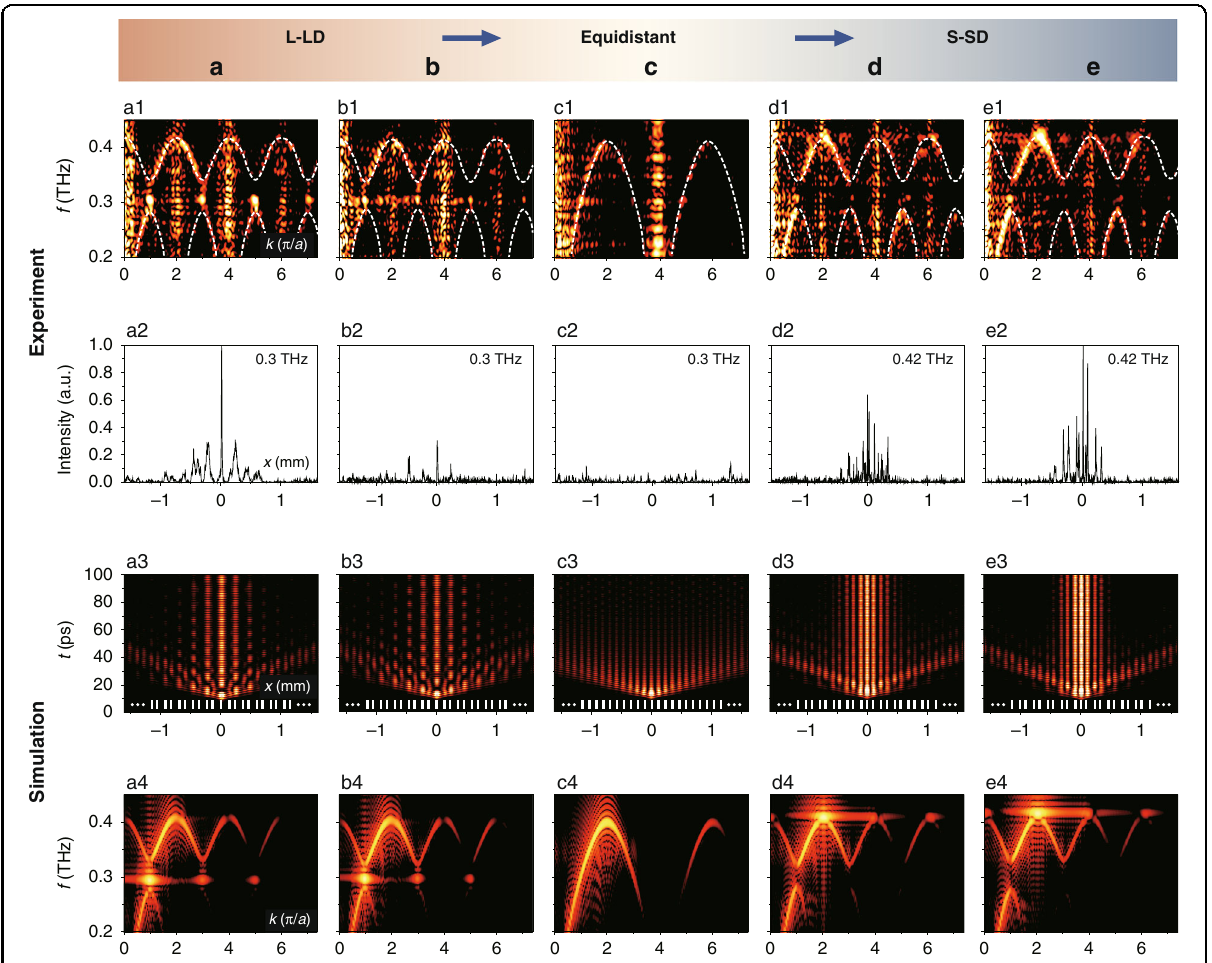
Fig. 3 Experimental (top two rows) and numerical (bottom two rows) demonstrations of topologically controlled THz con fi nement in the LN chip from L-LD, through equidistant, to S-SD regions of the wedge-shaped SSH photonic lattice. a – e correspond to locations (A – E) marked in Fig. 1b. a1 – e1 Measured spectra at the corresponding positions. a2 – e2 Energy distribution of the modes showing different con fi nement of the generated THz waves in the LN chip. a3 – e3 Simulated x − t diagrams showing the THz waves evolution in different regions, where a4 – e4 are the corresponding spectra. The lattice sites are illustrated by white tick marks in a3 – e3 , and a in ( a1 , a4 ) is the lattice constant for the corresponding L-LD